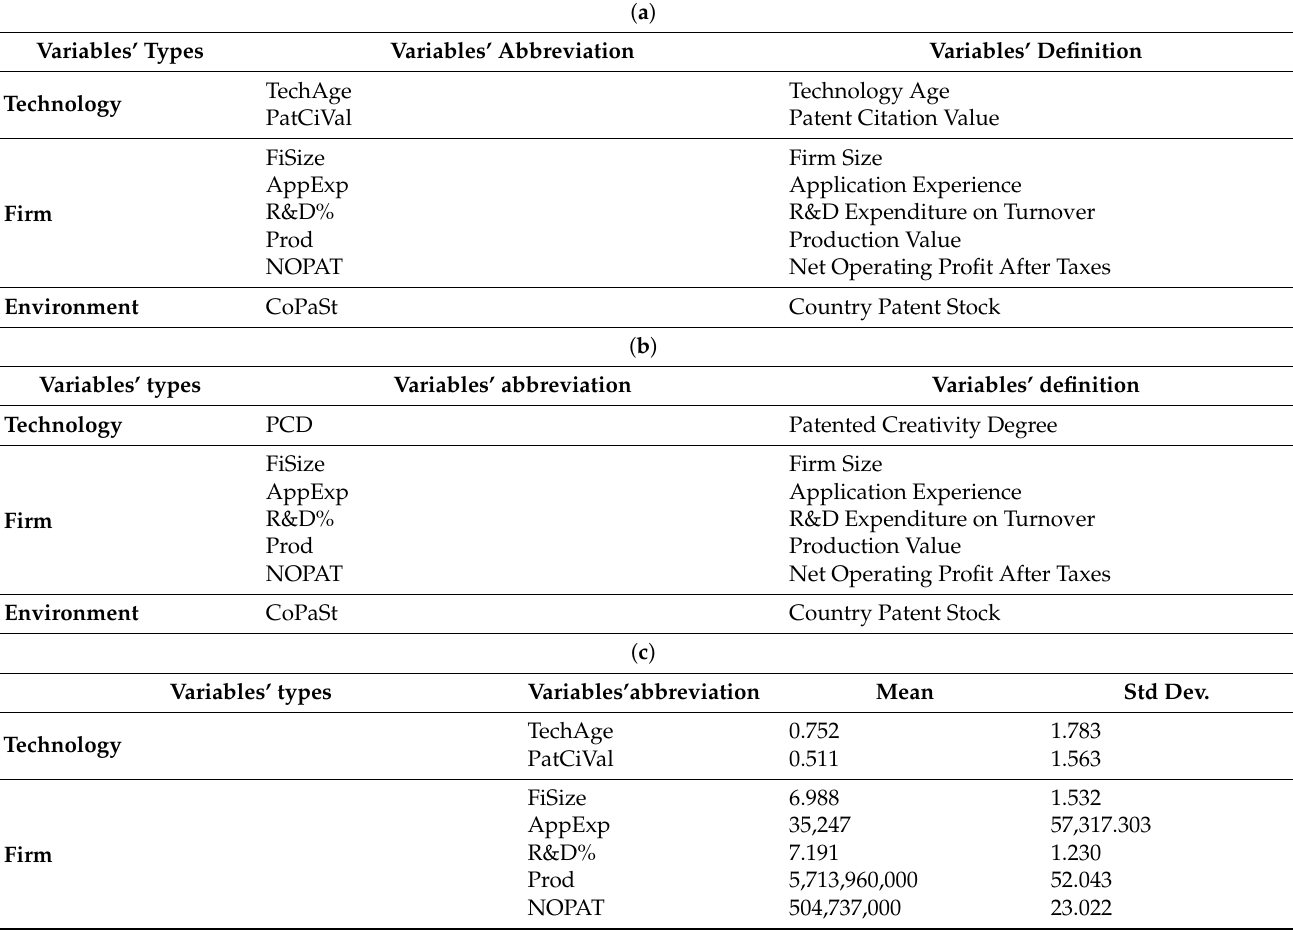
Table 1. (a) Control variables of knowledge model; (b) Control variables of creativity model; (c) Descriptive